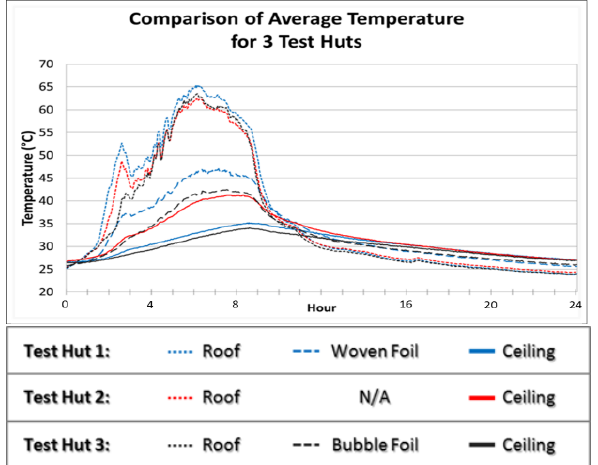
5. { RSI block } is within 25% of the running average (n+1) for RSI (Equation